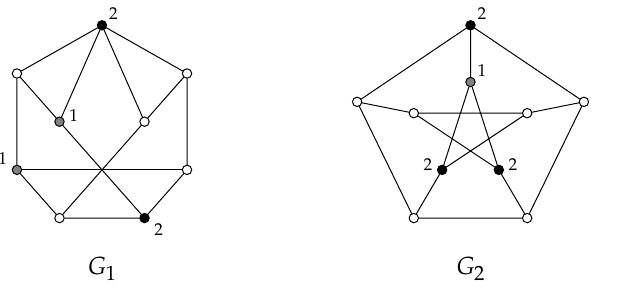
Figure 1. The labels of (gray and black) coloured vertices describe the positive weights of a γ qtR ( G i ) - function, for i ∈ { 1,2 }